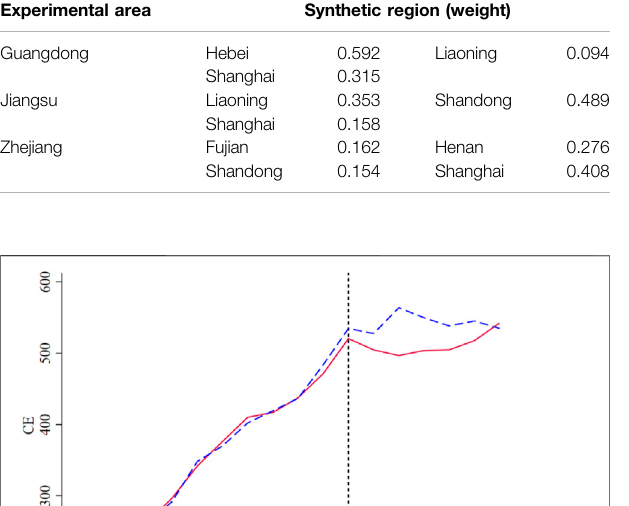
TABLE 4 | Weights of synthetic regions of experimental provinces. Experimental